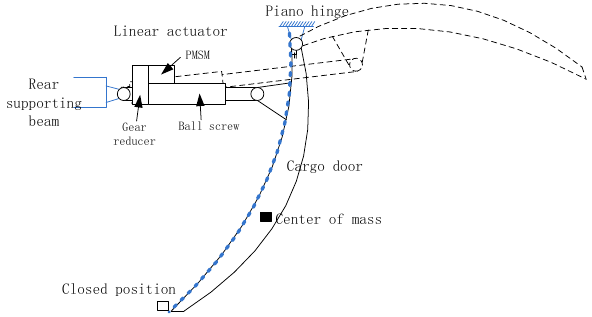
Figure 2. Function diagram of the cargo door actuation system.